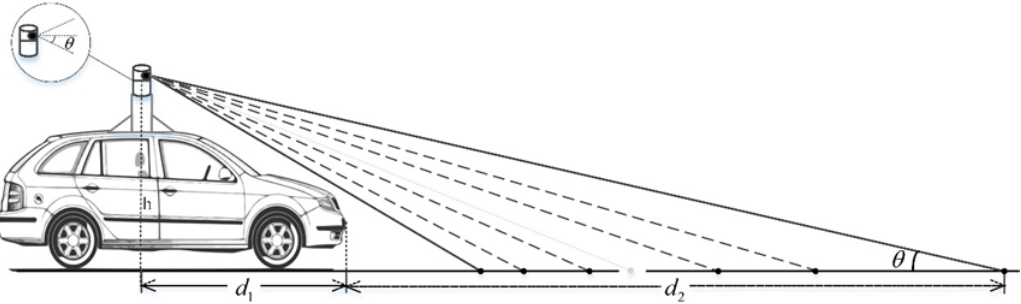
Figure 2. Schematic of 3D LIDAR vertical scanning range.